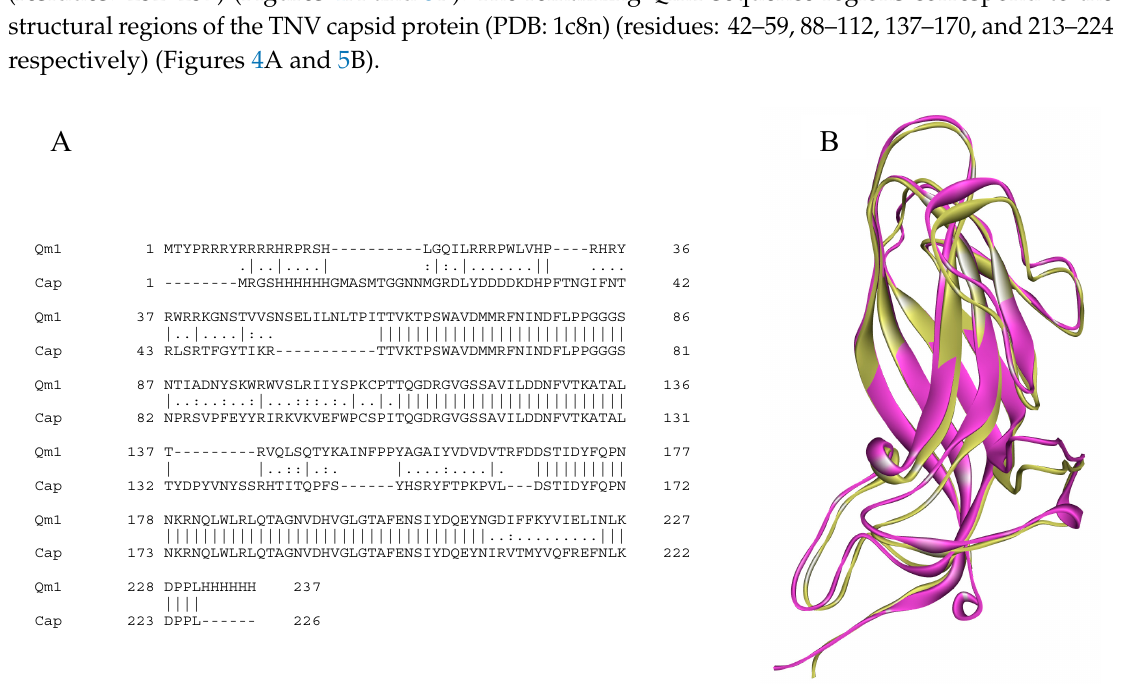
Figure 4. The sequence and structure comparison of the chimera 1 (Qm1) and PCV2 capsid protein (Cap). ( A ) The EMBOSS Needle alignment of the Cap (PDB: 3r0r) and Qm1 protein sequences. The sequences have 59.4% of identity and 67.5% of similarity according to the analysis. ( B ) The structural superposition the crystal structures of PCV2 (pink) and Qm1 (yellow).